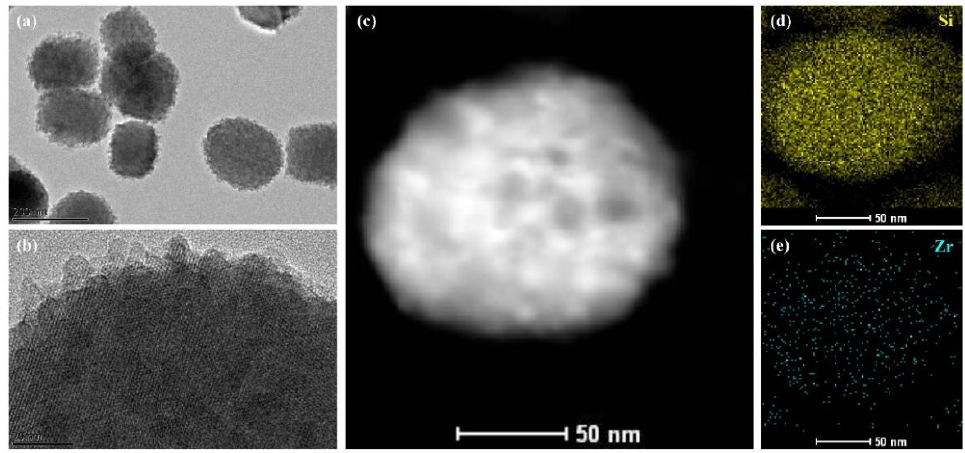
Figure 2. ( a , b ) TEM and ( c – e ) TEM-mapping images of Zr(40)-ZSM-5-st(500) catalyst.